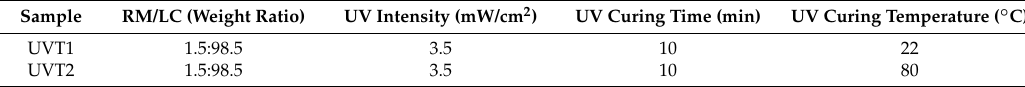
Table 6. With regard to the UV curing temperature, cells filled with 1.5% RM257 dissolved in E7 were UV cured at two temperatures (below and above the clearing point of E7), which is shown below. In each mixture, the added amount of PI was 1% with respect to the